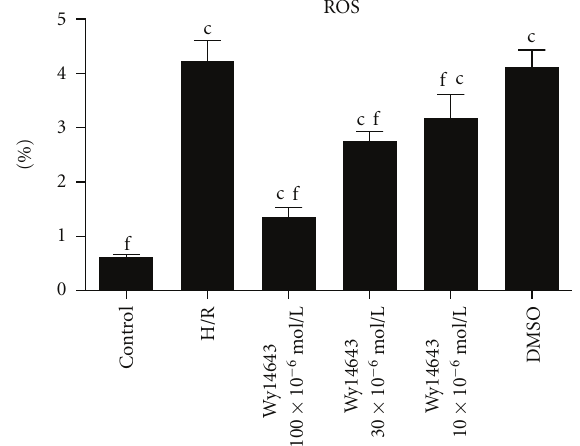
Figure 3: The content of ROS in di ff erent groups was determined by DCFH-DA (Mean ± SD, n = 6). After 4h of hepatocellular hypoxia and 10 h of reoxygenation. c P < 0 . 01 versus control group; f P < 0 . 01 versus H/R group.